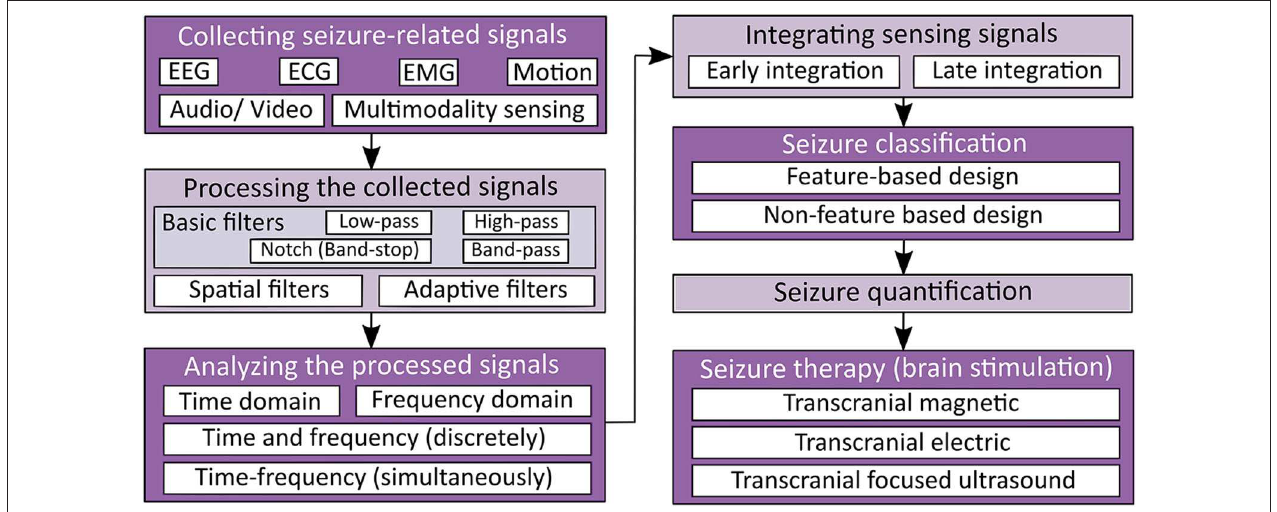
FIGURE 1 | Seizure detection and therapy